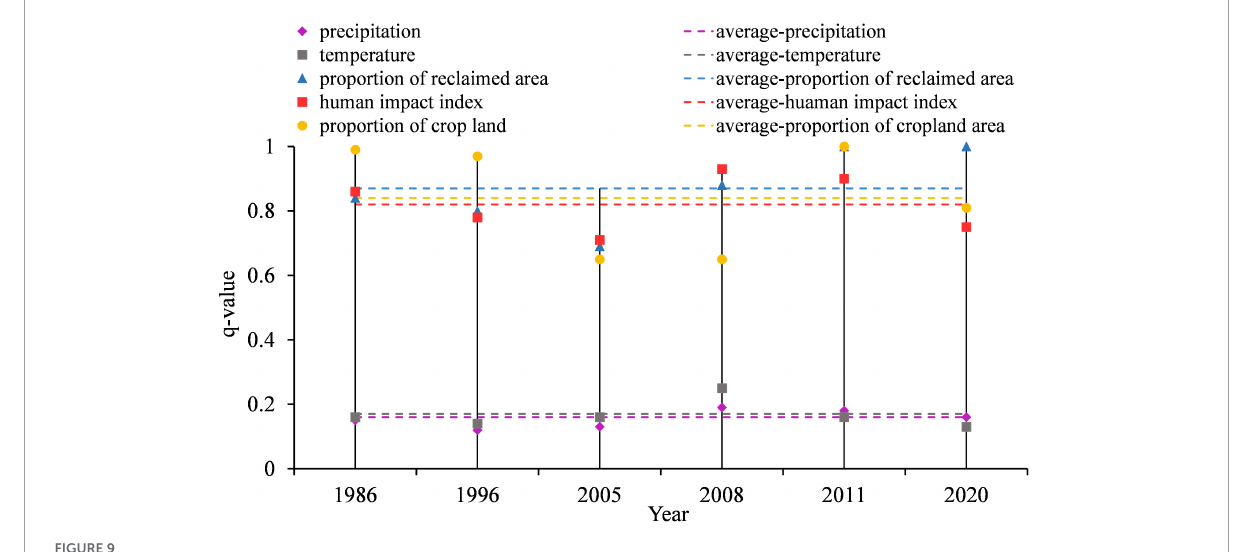
FIGURE9 The q -value of each factor’s influence on habitat quality.